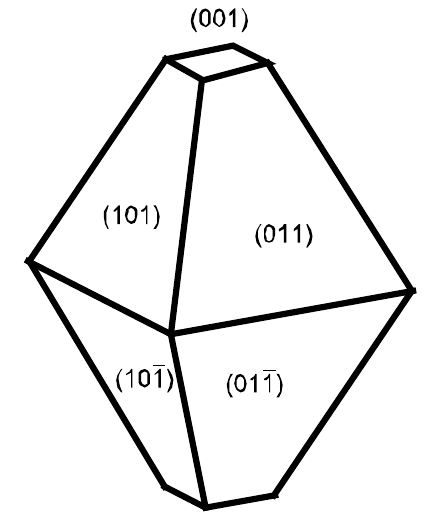
Figure 9. Equilibrium crystal shape of anatase: truncated bi-pyra-